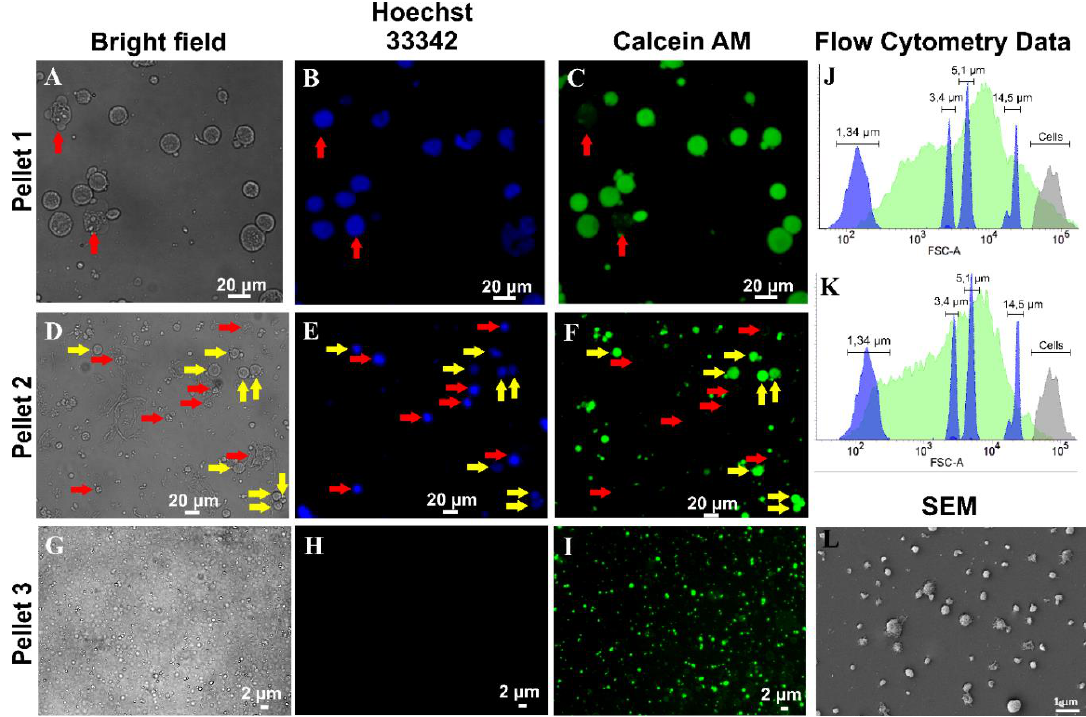
Figure 2. Characterization of CIMVs isolation by sequential centrifugation. Pellet 1 — cell components obtained after the first step of centrifugation at 100g for 10 min; Pellet 2 — cell components obtained after the second step of centrifugation at 300g for 20 min; Pellet 3 — CIMVs obtained after the third step of centrifugation at 2000g for 25 min. A – I — fluorescence microscopy, images were captured using ZEISS Axio Observer Z1 microscope. J,K — Flow cytometry analysis. Blue — calibration particles (1.34, 3.4, 5.1, 14.5 μm), grey — native cells, green — pellet components. L — scanning electron microphotograph of CIMVs.